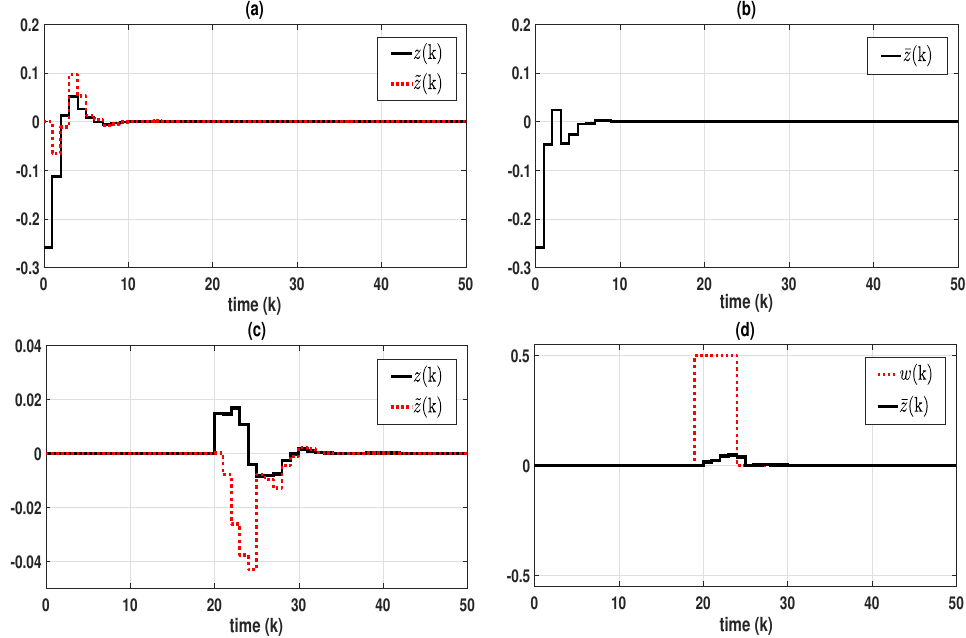
Figure 3. Filter response: ( a , b ) z ( k ) , ˜ z ( k ) , and ¯ z ( k ) for x ( 0 ) (cid:54) = 0 and w ( k ) ≡ 0; and ( c , d ) z ( k ) , ˜ z ( k ) , and ¯ z ( k ) for x ( 0 ) ≡ 0 and w ( k ) (cid:54) =